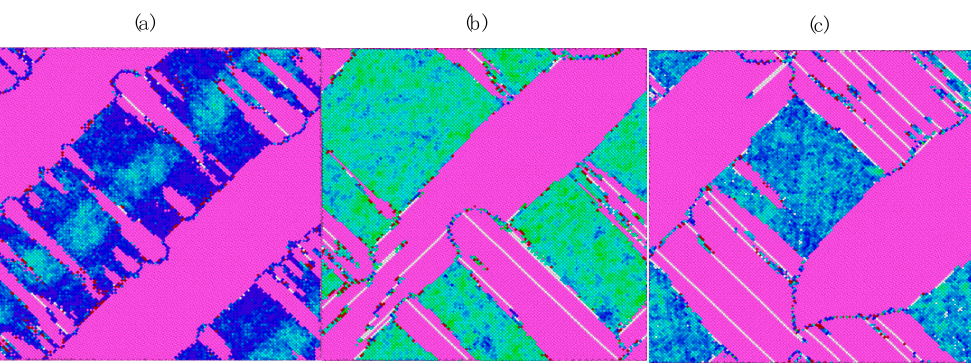
Figure 6. Snapshots of atom configurations showing a cross-section of the phase transformation front once compression overcomes the hardening-like effect scenario (i) for a ramp compression rise time of 30 ps ( a ), 45 ps ( b ), and 60 ps ( c ).